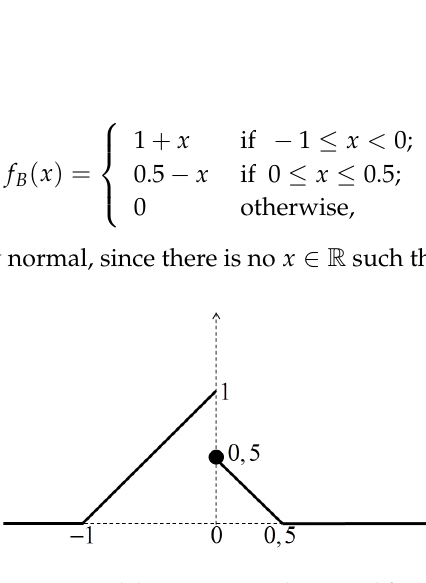
Figure 1. Normal, but non-strongly normal fuzzy set.